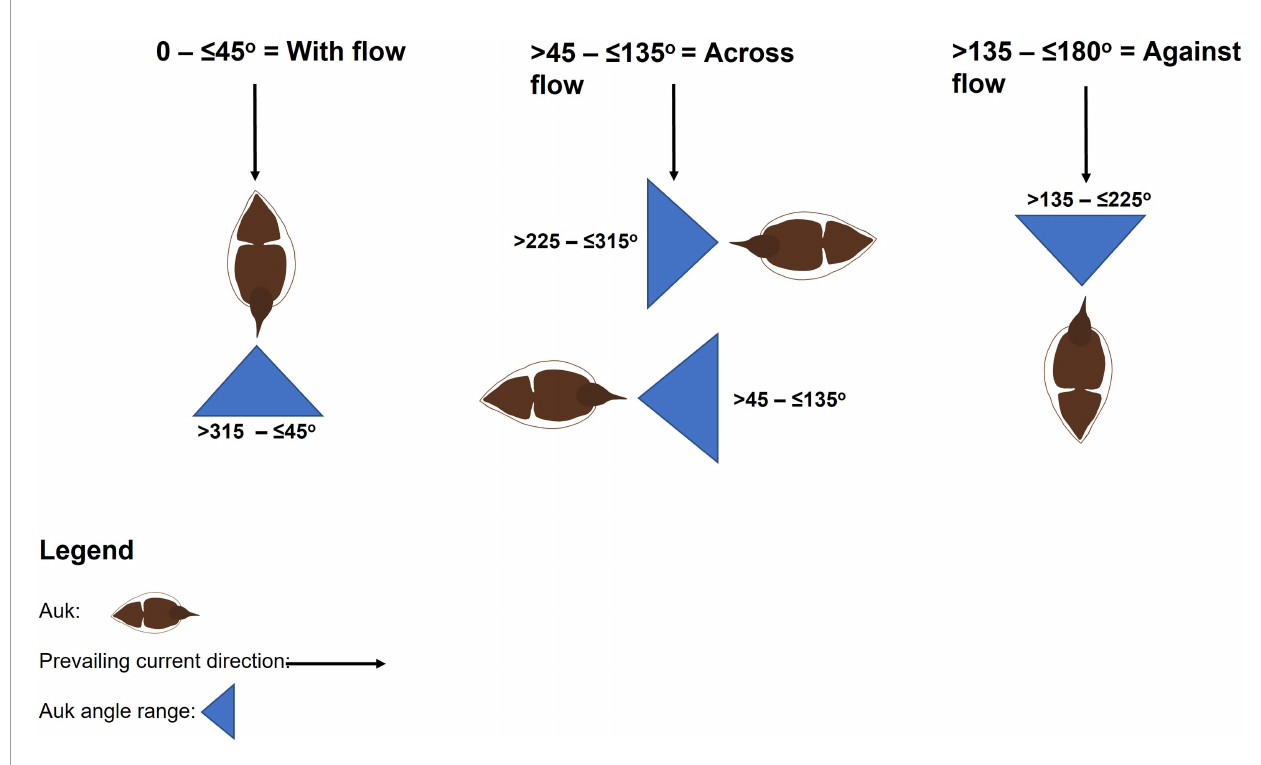
FIGURE 3 | Classi fi cations of auk orientation relative to fl